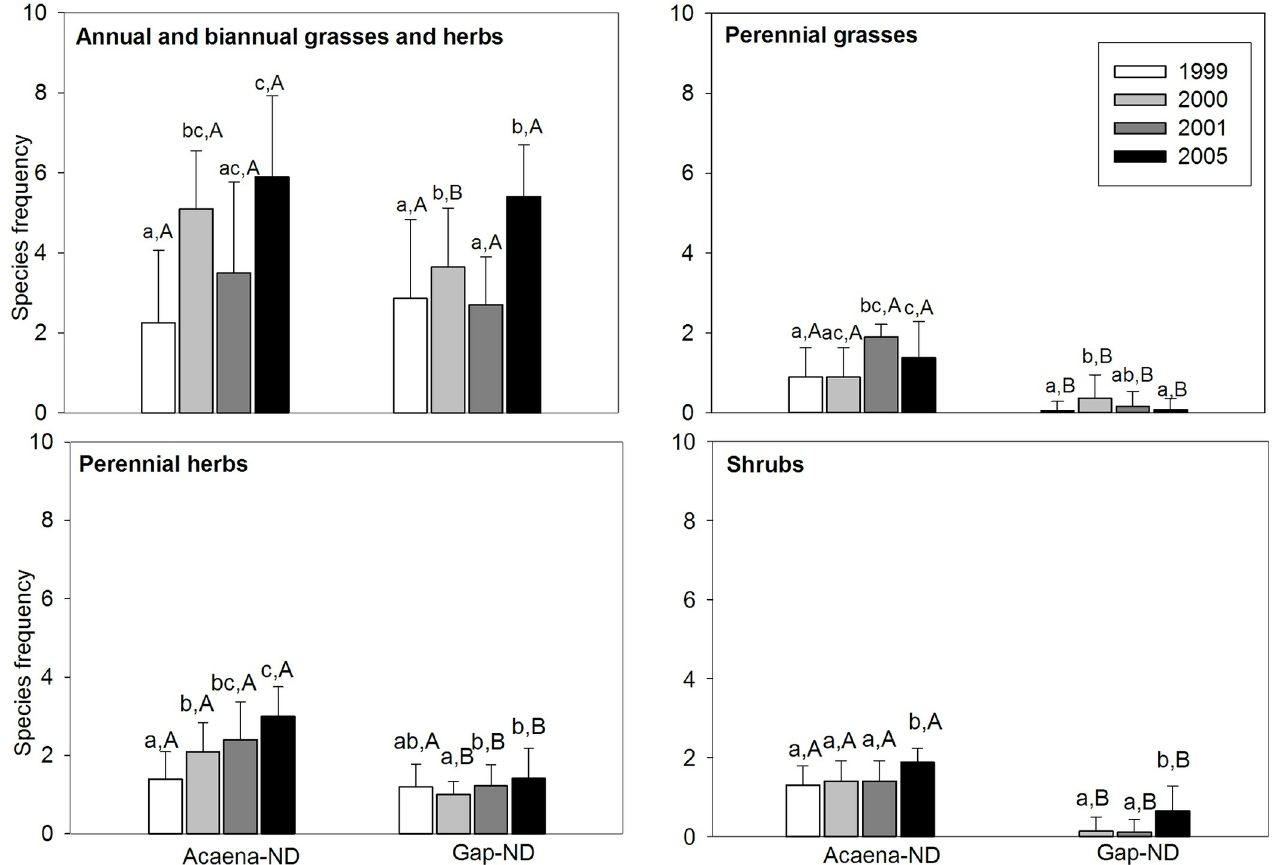
Fig 3. Functional groups in Acaena-ND and Gap-ND microsites. Mean frequency of species ± SD grouped in functional groups in Acaena-ND and Gap-ND in non-degraded grassland (November 1999, 2000, 2001 and 2005). Lower-case letters indicate significant differences of each functional group between years in the same microsite. Capital letters represent significant differences between microsites in the same